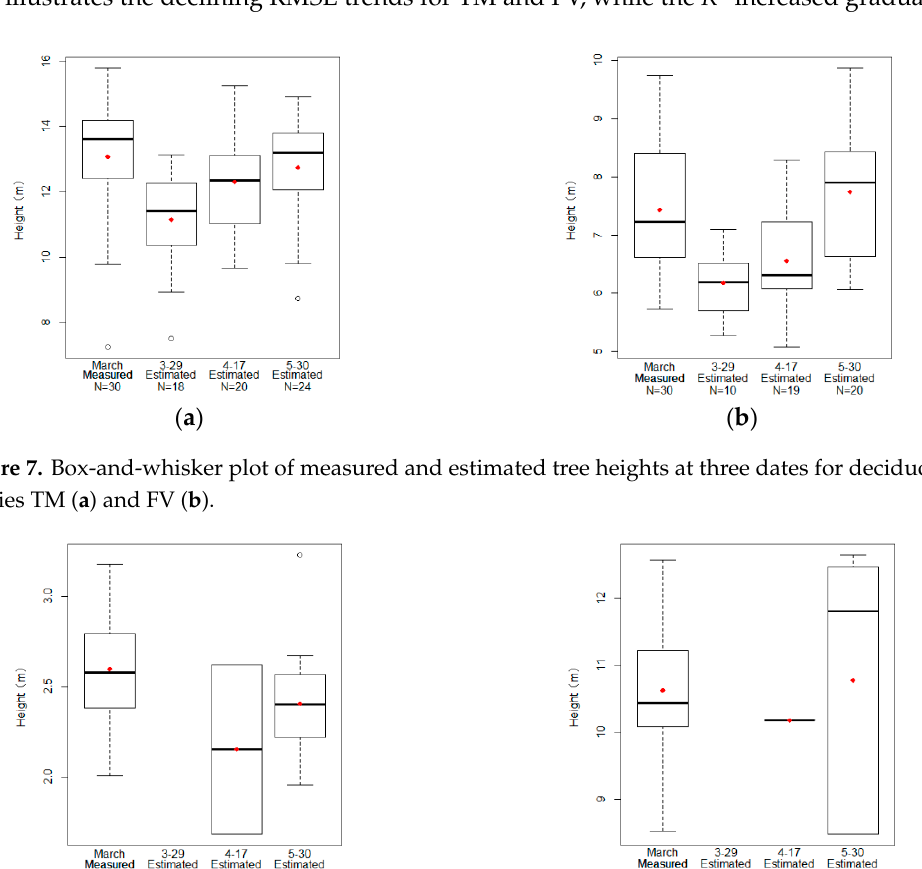
Figure 6. Tree height estimation root mean square errors (RMSEs) and R 2 values of evergreen species AS ( a ) and OF ( b ) on the three dates. The blue dots and lines are for the RMSEs, while the red dots and lines are for the R 2 values.